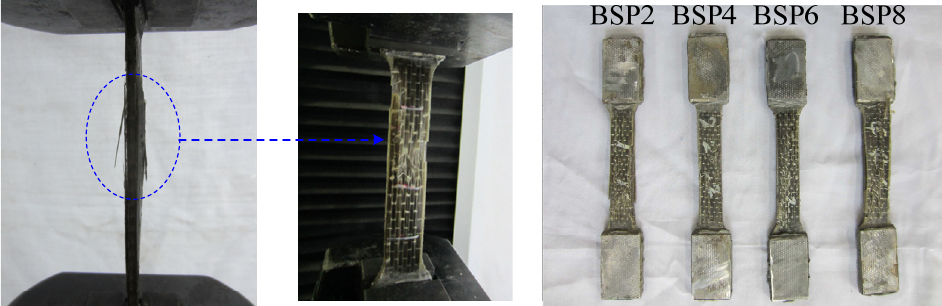
Figure 7. Typical failure of a BSP specimen.